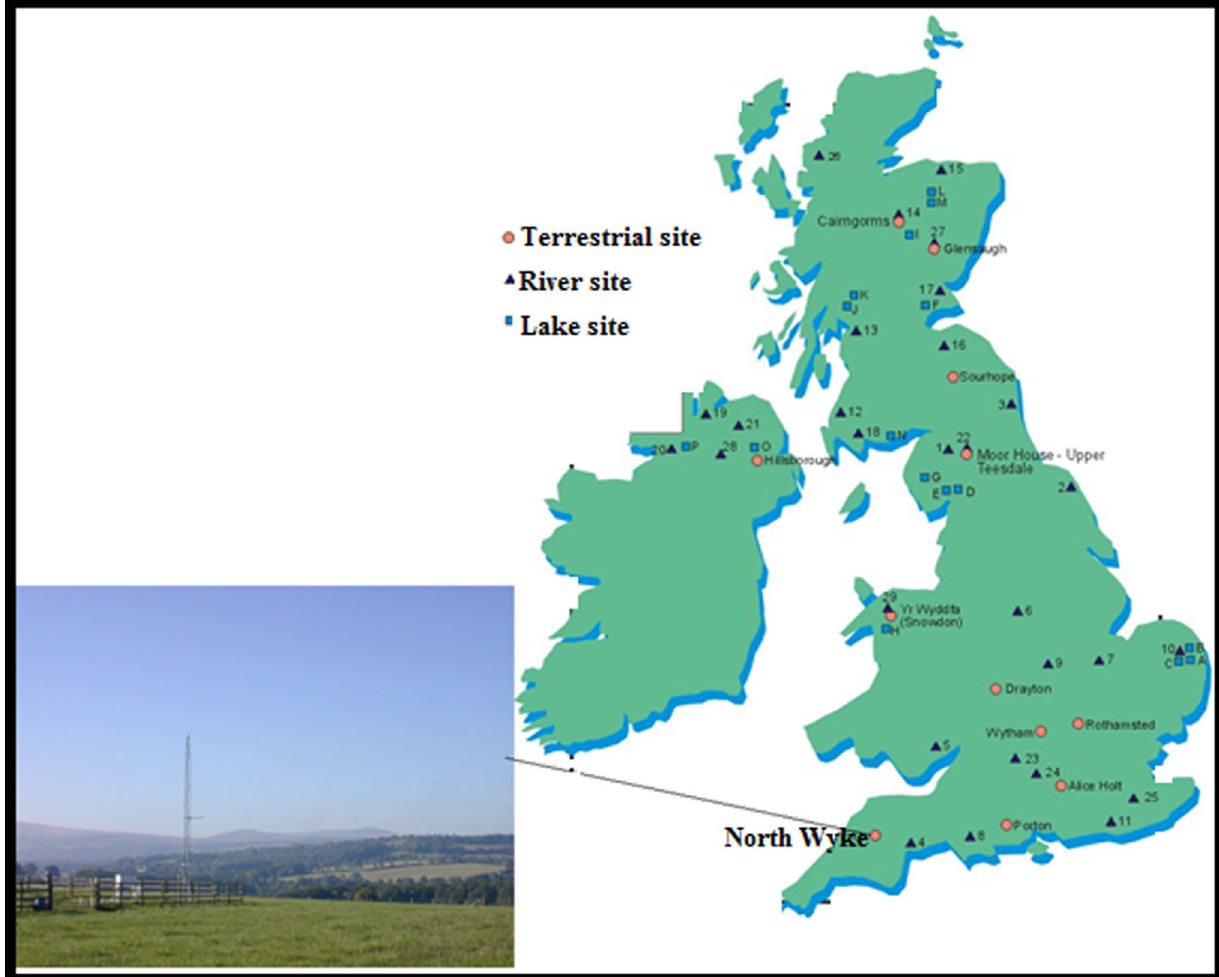
Fig. 1 Environment change network’s terrestrial site at the North Wyke Farm platform in southwest